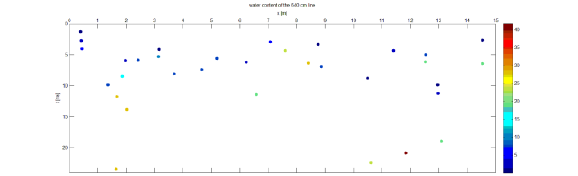
Figure 12. Subsurface soil moisture content calculated from the electromagnetic wave velocity using a simple model based on information from the laboratory